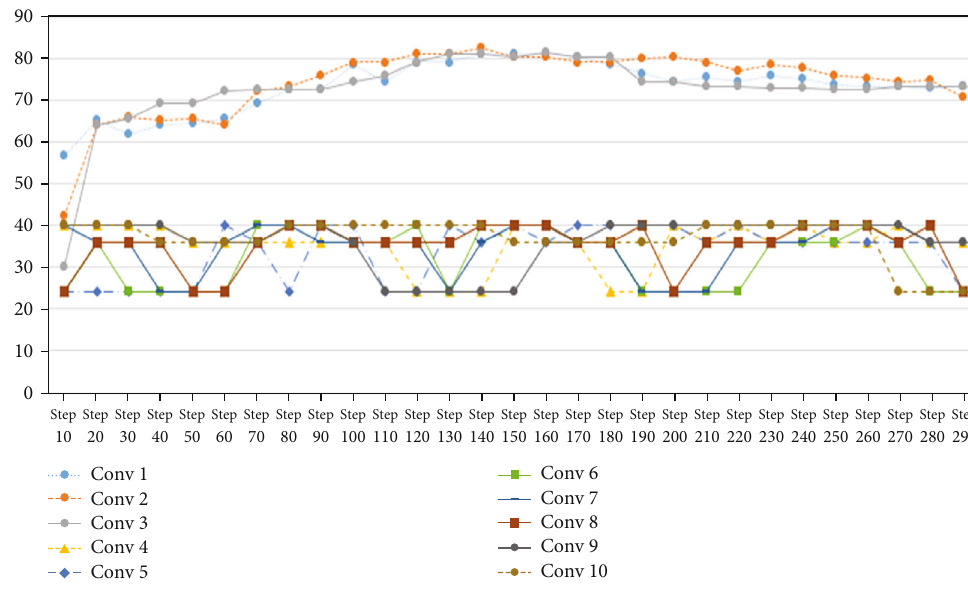
Figure 5: Comparison of the accuracy of the convolution layer without ReLu, maxpool, and dropout.